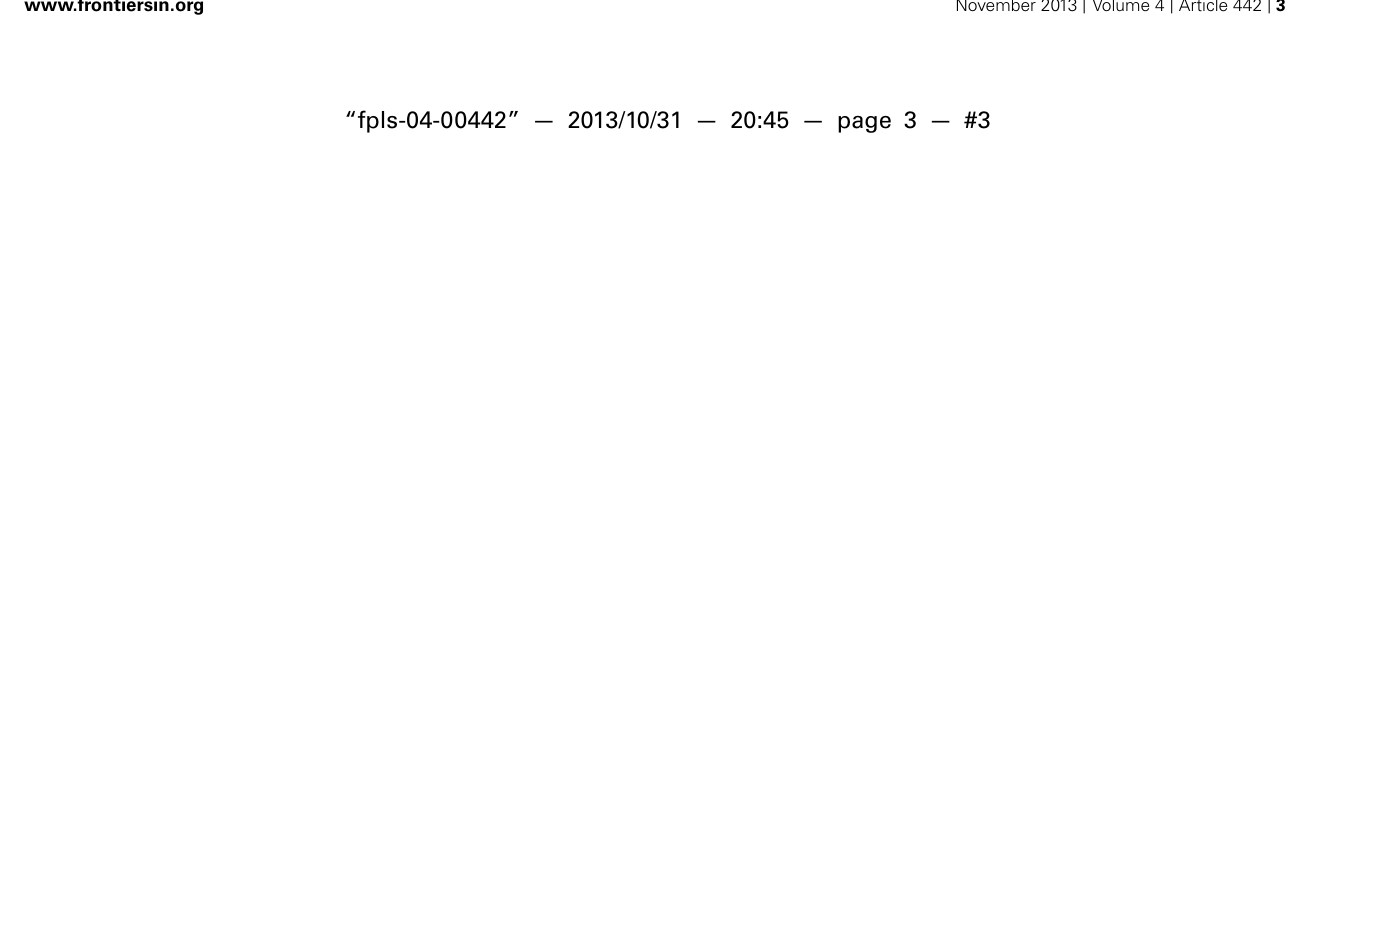
single root types (e.g., fine roots), and tissue or cell to single cell types (e.g., xylem or cortical cells). Root traits in black text are traits that have been shown to be related to drought tolerance, and gray italic those that may be associated with drought tolerance but either require more research or have been